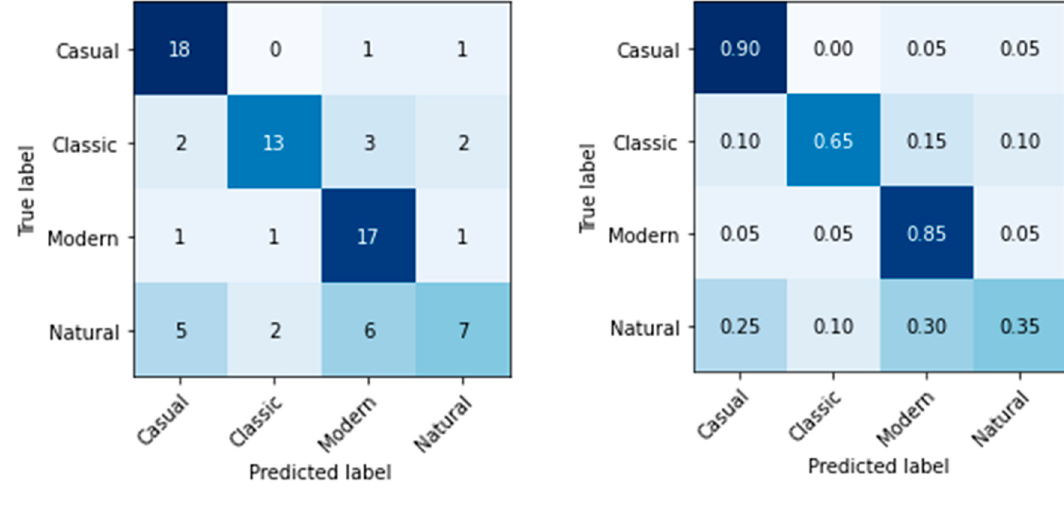
Figure 6. Confusion matrices of results of recognition testing of the trained model.